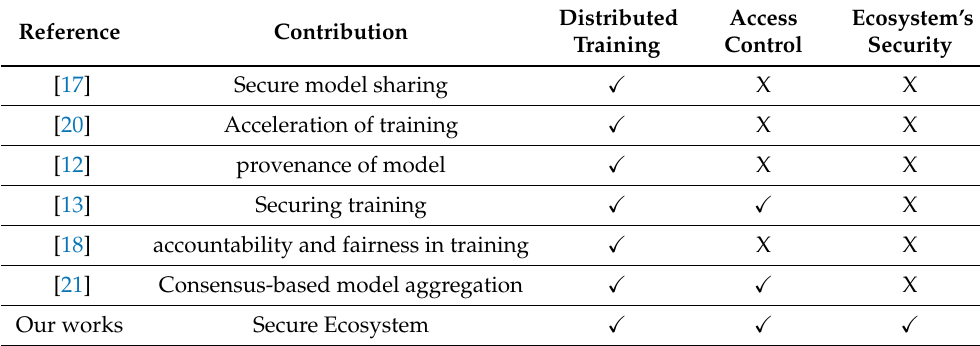
Table 1. Summary of related contributions.